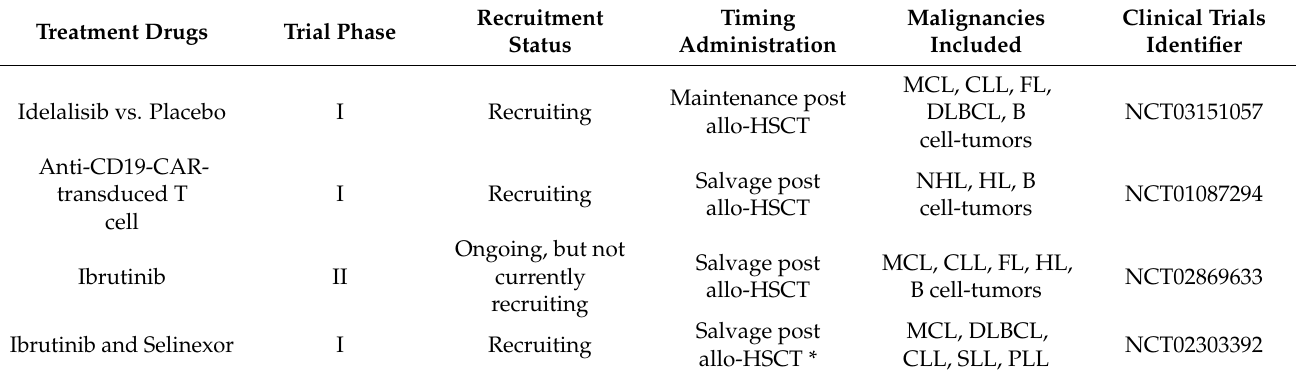
Table 2. Ongoing clinical trials enrolling patients with MCL after allogeneic transplantation. Treatment Drugs Trial